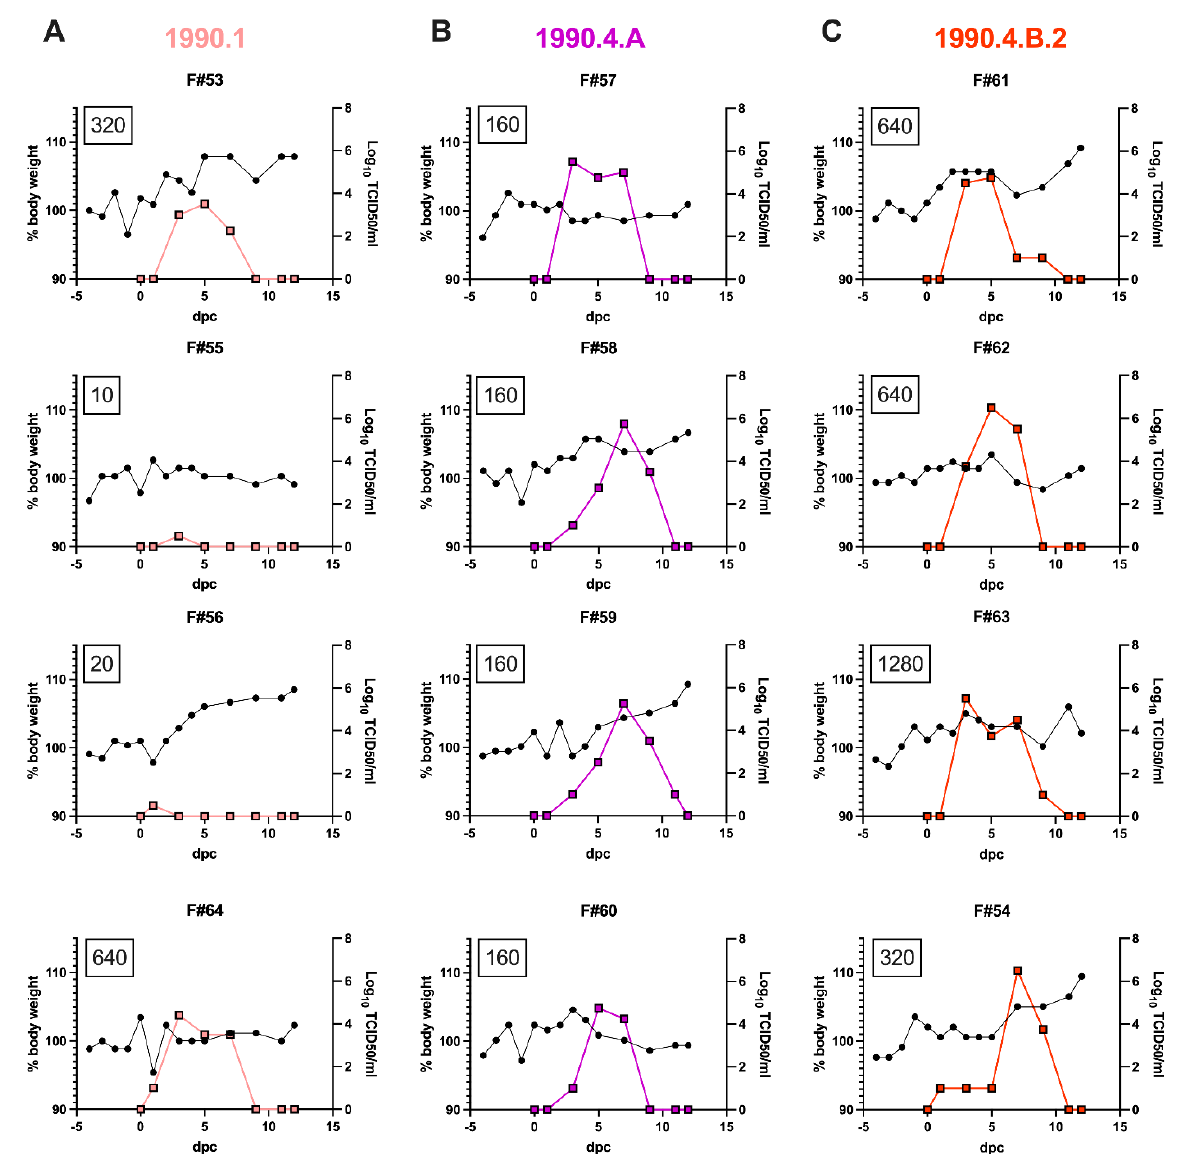
Figure 3. Swine H3N2 transmitted to ferrets. Percent body weight change and nasal wash virus titers were recorded for individual ferrets exposed to 1990.1 ( A ), 1990.4.A ( B ), and 1990.4.B.2 ( C ) swine H3N2 strains. Ferret body weight was taken daily and recorded as a percentage of the − 3 day average body weight prior to exposure (left axis, black circles). Nasal washes were measured for viral shedding by TCID 50 in MDCK cells and recorded as log 10 TCID 50 /mL (right axis, color square). The black boxed numbers indicate the HI titers of sera collected at 12 days post contact